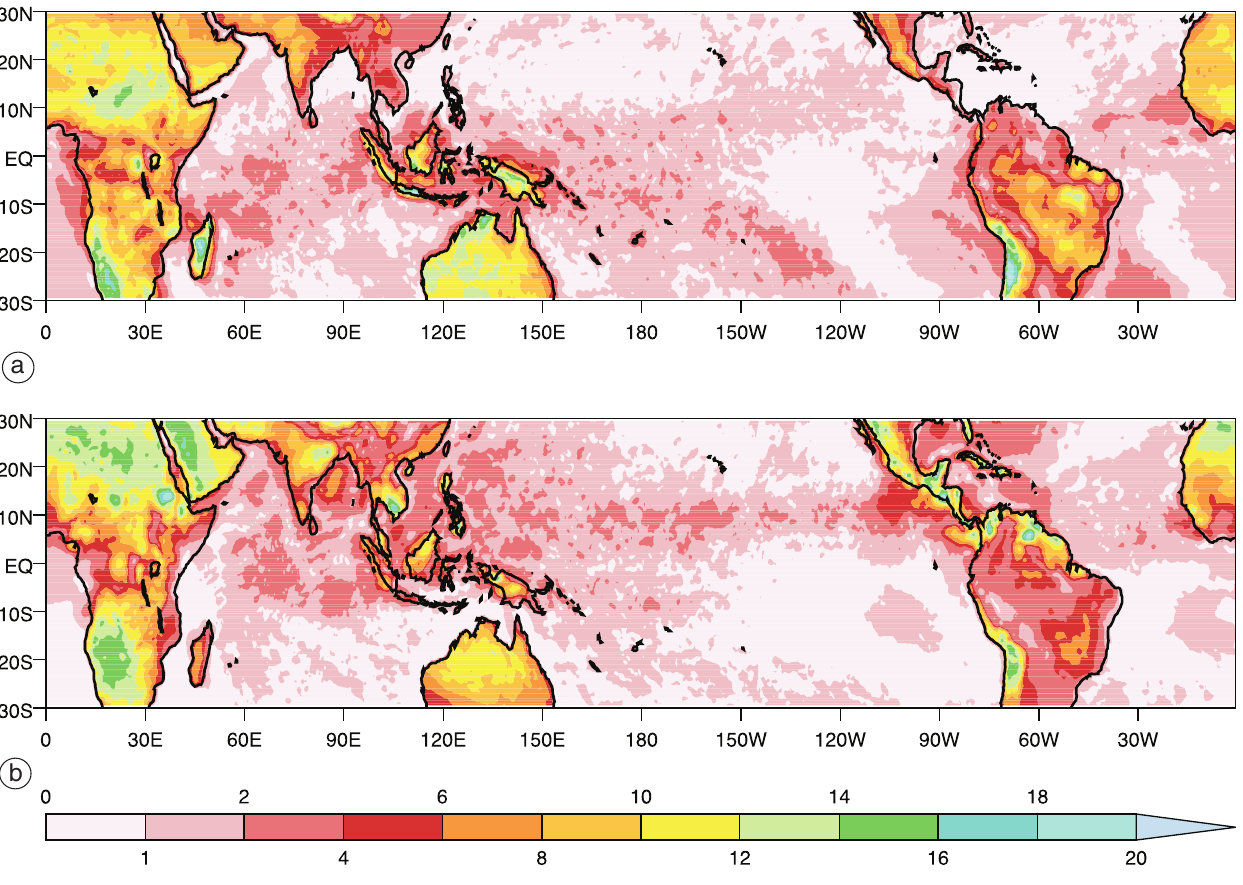
Fig. 4a,b. Seasonal mean amplitude of the diurnal harmonic in brightness temperature (K) for DJF (a) and JJA (b). From Yang and Slingo